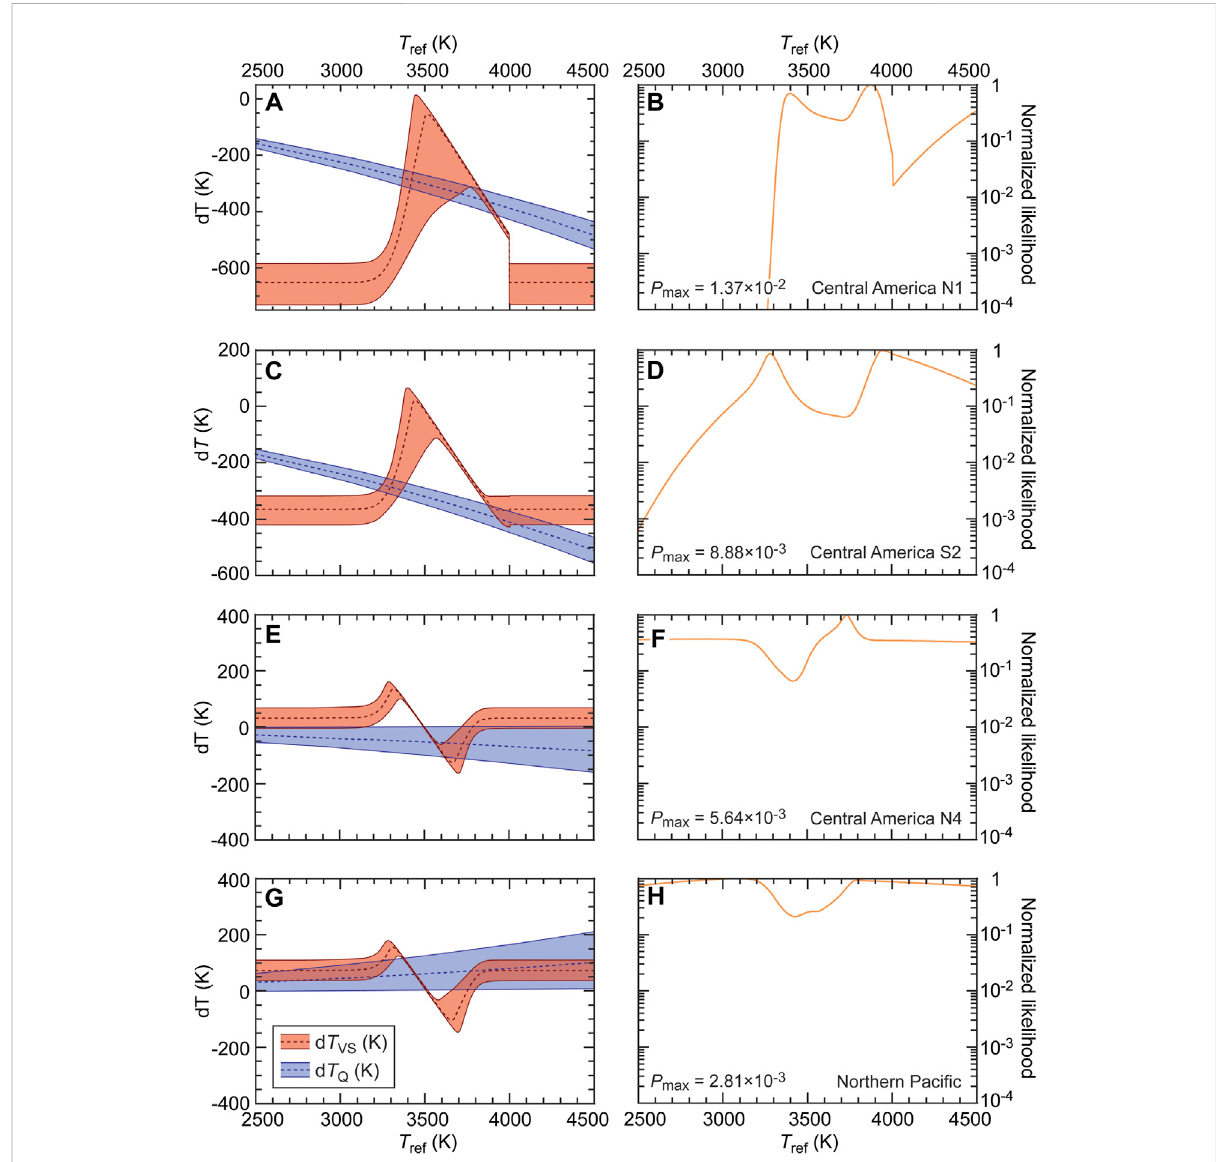
Distribution in d T VS and d T Q (left column) and corresponding likelihoods (right column) as a function of T ref and at different locations: Central America N1 (A,B) ; Central America S2 (C,D) ; Central America N4 (E,F) ; and Northern Paci fi c (G,H) . Dashed curves in distribution plots show the median (de fi ned as the 0.5 pdf quartile, i.e. , T ref lie on each side of this value with a 50% likelihood) in d T VS and d T Q , and the coloured areas cover 68.3% of the pdfs around their median values. Likelihood (right column) are normalized with their maximum values and plotted with a logarithmic scale. The frequency exponent, activation enthalpy, and transition temperature to pPv are set to α = 0.274, H = 440 kJmol -1 , and T pPv = 3500 K. For other details of the calculations, see text and Table